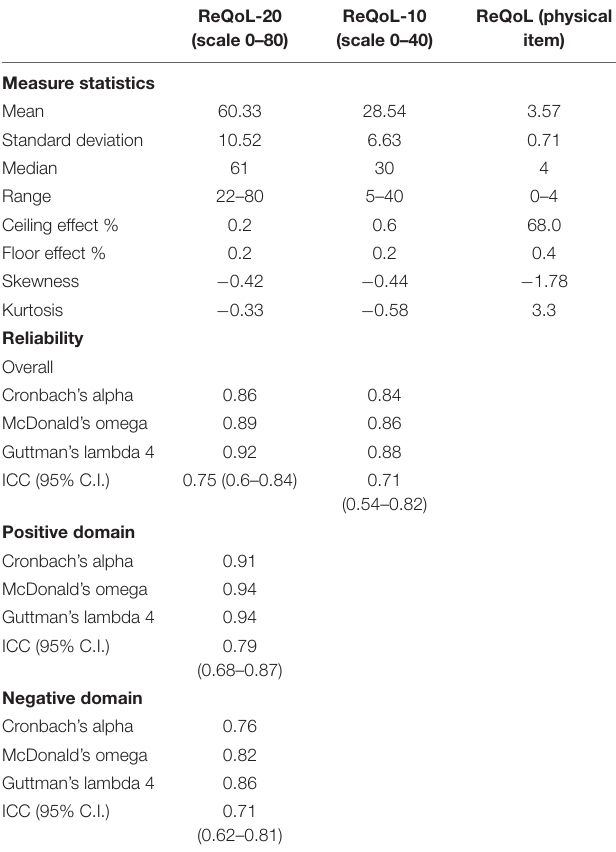
TABLE 4 | Score distribution and internal consistency and test–retest reliability of